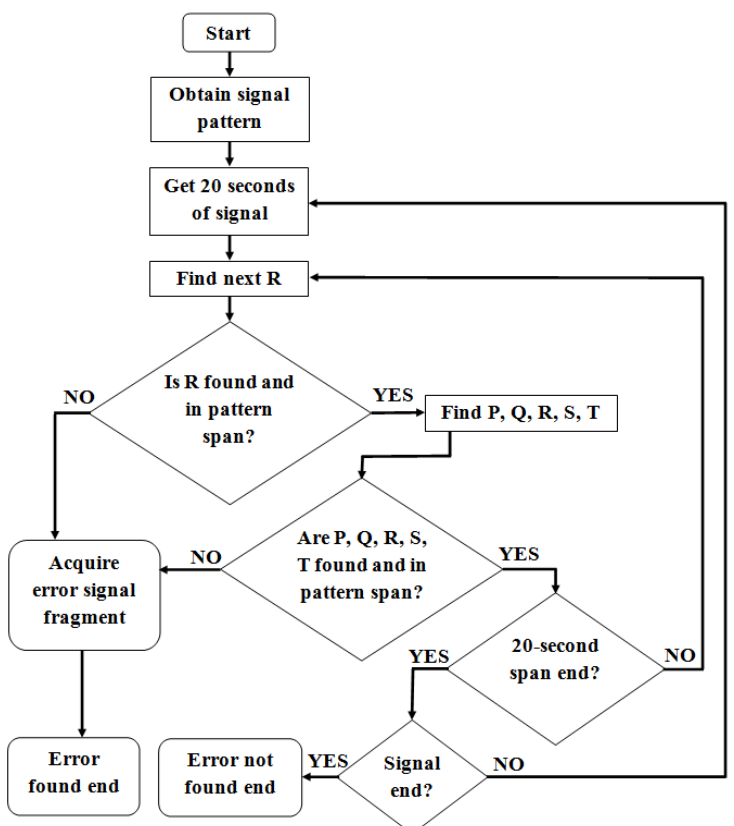
Figure 4. Flowchart of real time simulation.